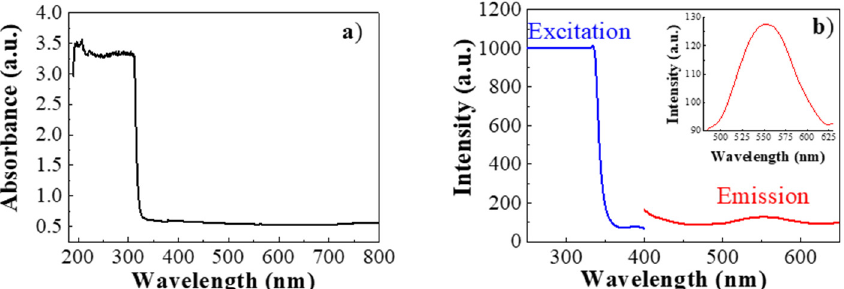
Figure 2. UV–Vis absorption spectrum of CsI(Tl) (slice of 0.883 mm) ( a ), and UV–Vis excitation– emission spectra of CsI(Tl) ( b ). In the inset, a magnification of the emission peak is